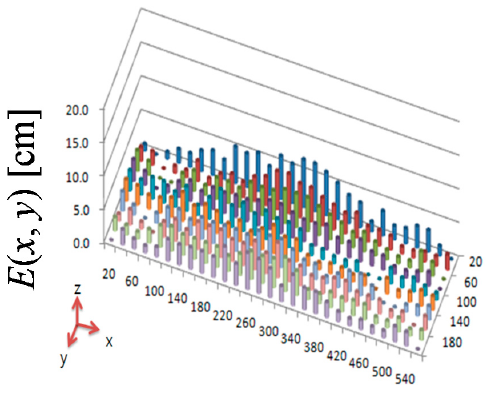
Figure 17. Position error estimate after error compensation.